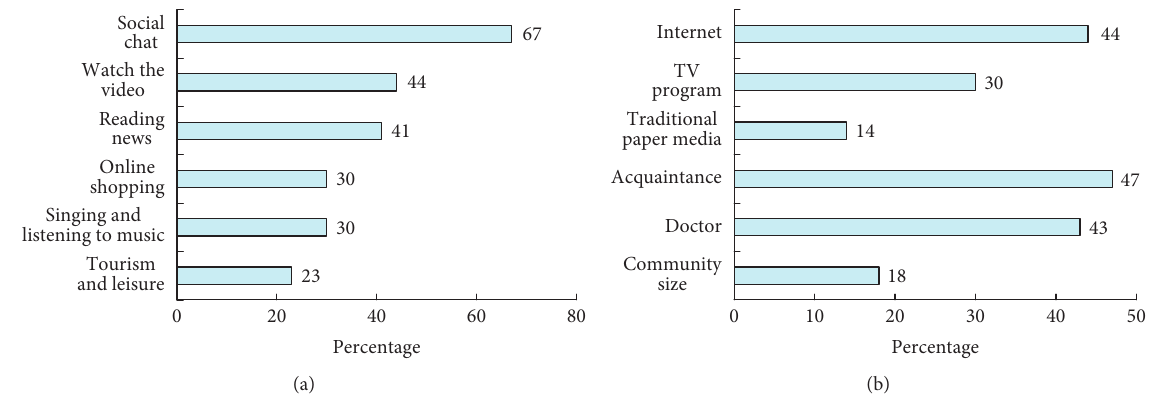
Figure 3: The type and proportion of elderly people’s online attention to content and access to health knowledge. (a) Content and proportion of elderly people’s online attention. (b) The corresponding types and proportions of knowledge acquisition.